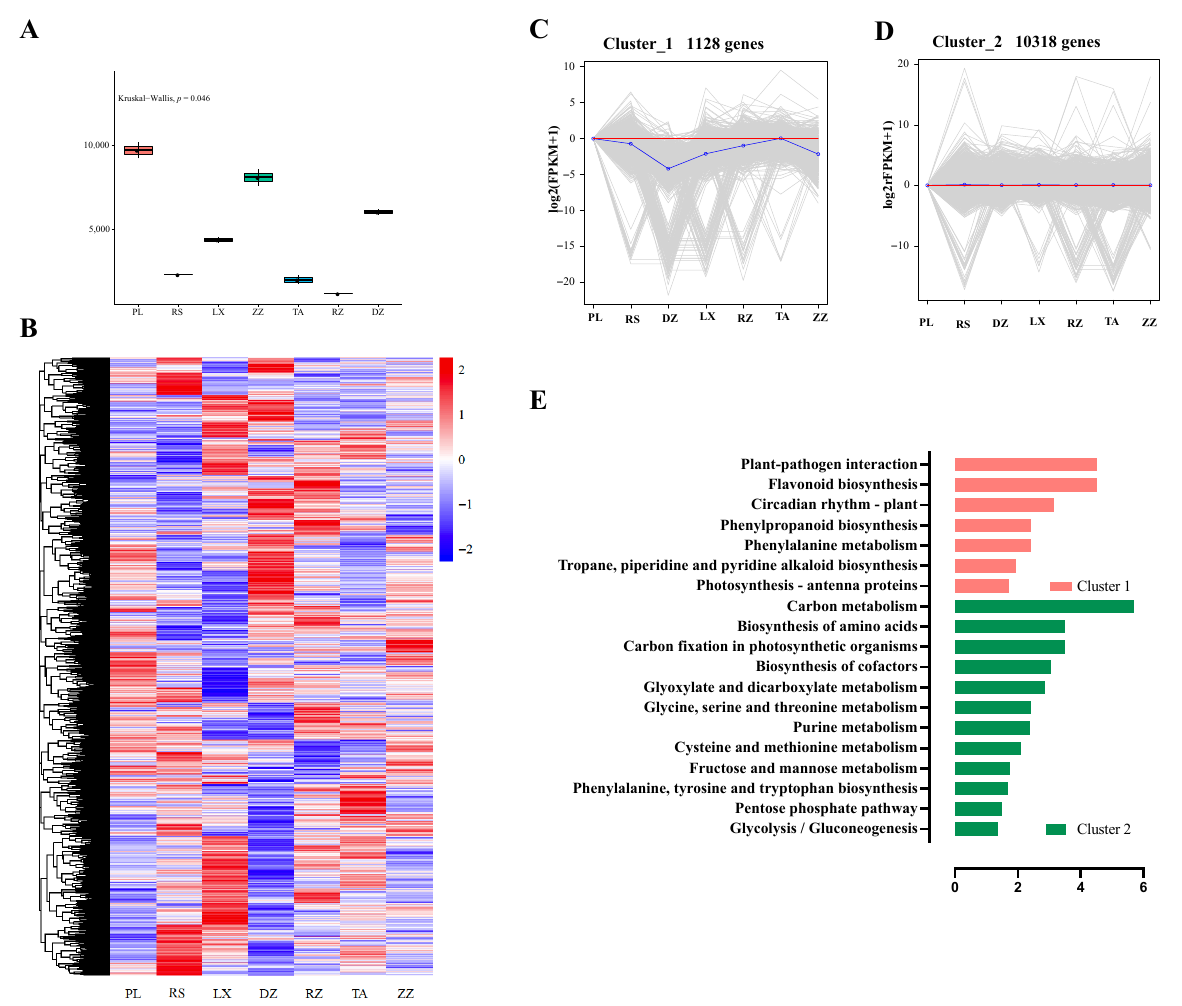
Figure 4. Classification of transcriptomic data of the localized grape berries at maturity in different regions. Seven regions were included DZ, LX, PL, RZ, RS, TA, and ZZ. ( A ) Kruskal-Wallis test at maturity. ( B ) Heatmap analysis using FPKM values of genes in different regions at maturity. ( C , D ) K_means clustering analysis of 11,783 genes into two groups. ( E ) Histogram showing the involvement of metabolic pathways of the classified genes in Cluster1 and Cluster2 at maturity. The abscissas represent the GeneRatio, and ordinate represents KEGG pathway. The GeneRatio refers to the ratio of the sample number to the background number enriched in the